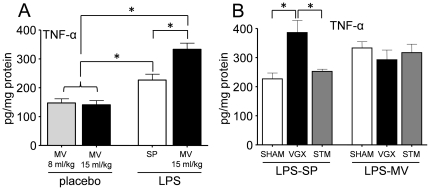
Effects of ventilation with 15 mL/kg in LPS- or placebo-pretreated rats, and vagus nerve stimulation/vagotomy on pulmonary inflammation.A: Pulmonary concentrations of TNF-α in placebo- and LPS-treated spontaneously breathing (SP) and mechanically ventilated (MV, 8 or 15 mL/kg) rats. B: Pulmonary concentrations of TNF-α in LPS-treated spontaneously breathing and mechanically ventilated (15 mL/kg) rats that underwent a sham operation (SHAM), bilateral vagotomy (VGX) or vagus nerve stimulation (STM). Pulmonary cytokine levels are normalized to the total amount of protein in each lung homogenate. Data are represented as mean ± SEM of 6–8 animals per group. * indicates p<0.05, one-way ANOVA with Bonferroni post-hoc test.